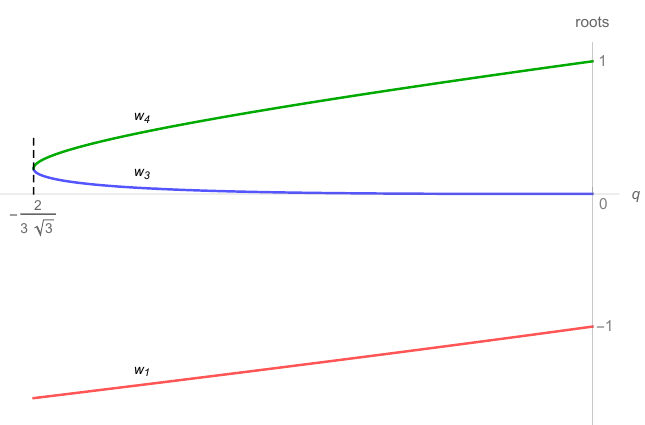
Figure 3 . The values of the three roots of f ( w ) /w as a function of q in the T 3 truncation. The root w 3 approaches zero as q → 0 but is positive for all values in the range q ∈